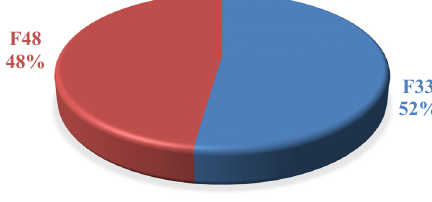
Figure 7: Local impact of factors in the bidding stage.